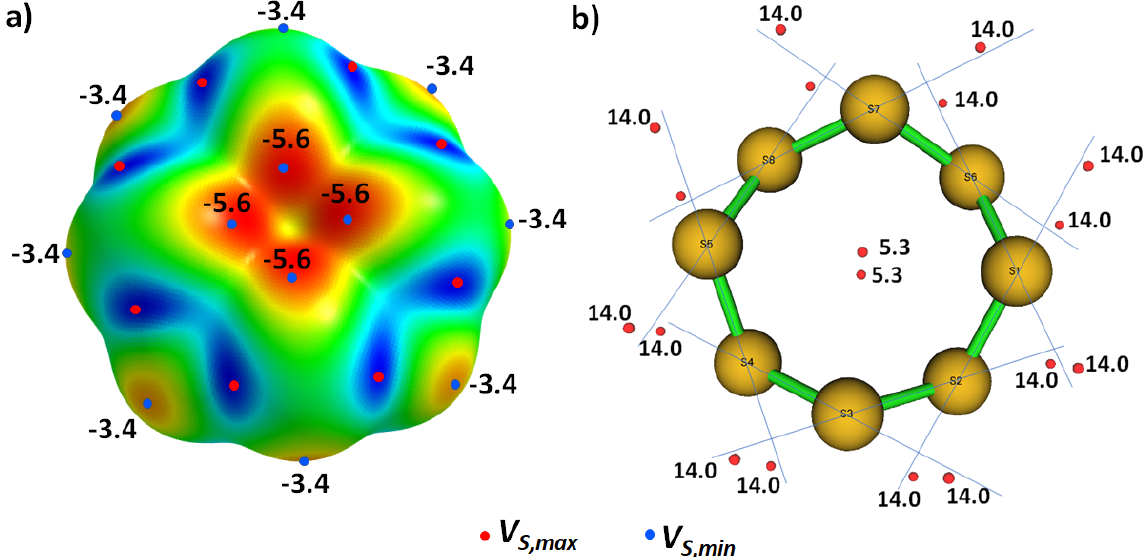
Figure 5. ( a ) ω B97XD/aug-cc-pVTZ computed 0.0015 a.u. isoelectron density mapped potential on the electrostatic surface of the S 8 molecule. ( b ) Illustration of the molecular framework, with only the local most maximum of potential ( V S,max ) along the outer extensions of the S–S covalent bonds. Values of the local most minima of potential ( V S,min ) on the electrostatic surface of the S 8 molecule is shown in ( a ). Values of V S,max and V S,min are in kcal mol − 1 .